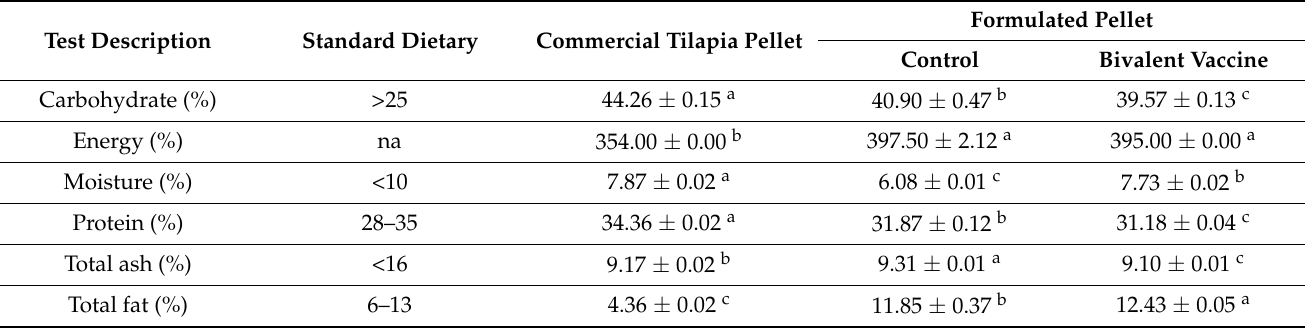
Table 1. Proximate compositions of a commercial tilapia pellet and the formulated pellets.